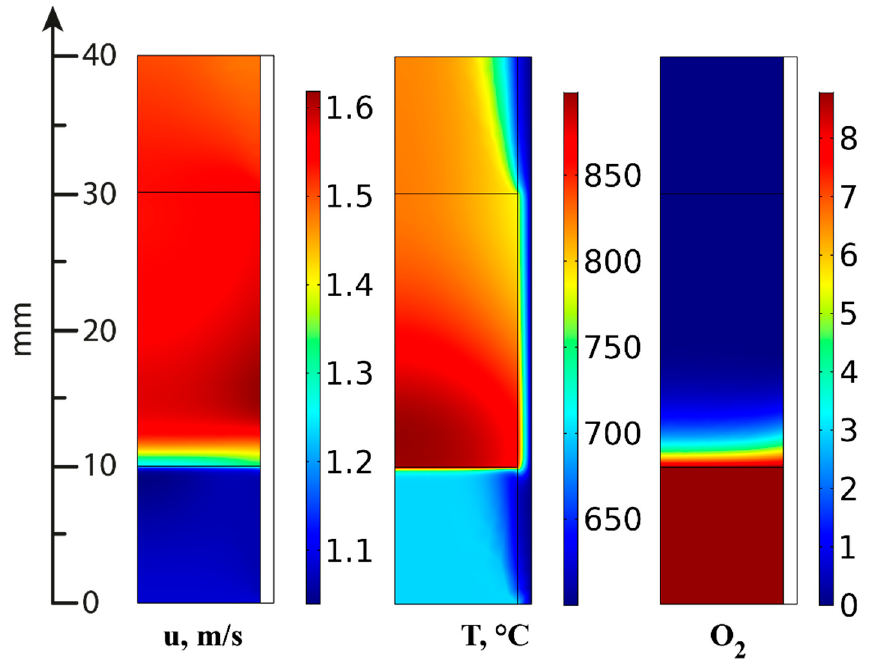
Figure 21. Gas velocity ( left ), temperature distribution ( center ) and oxygen concentration ( right ; vol.%) in ATR mode [95].